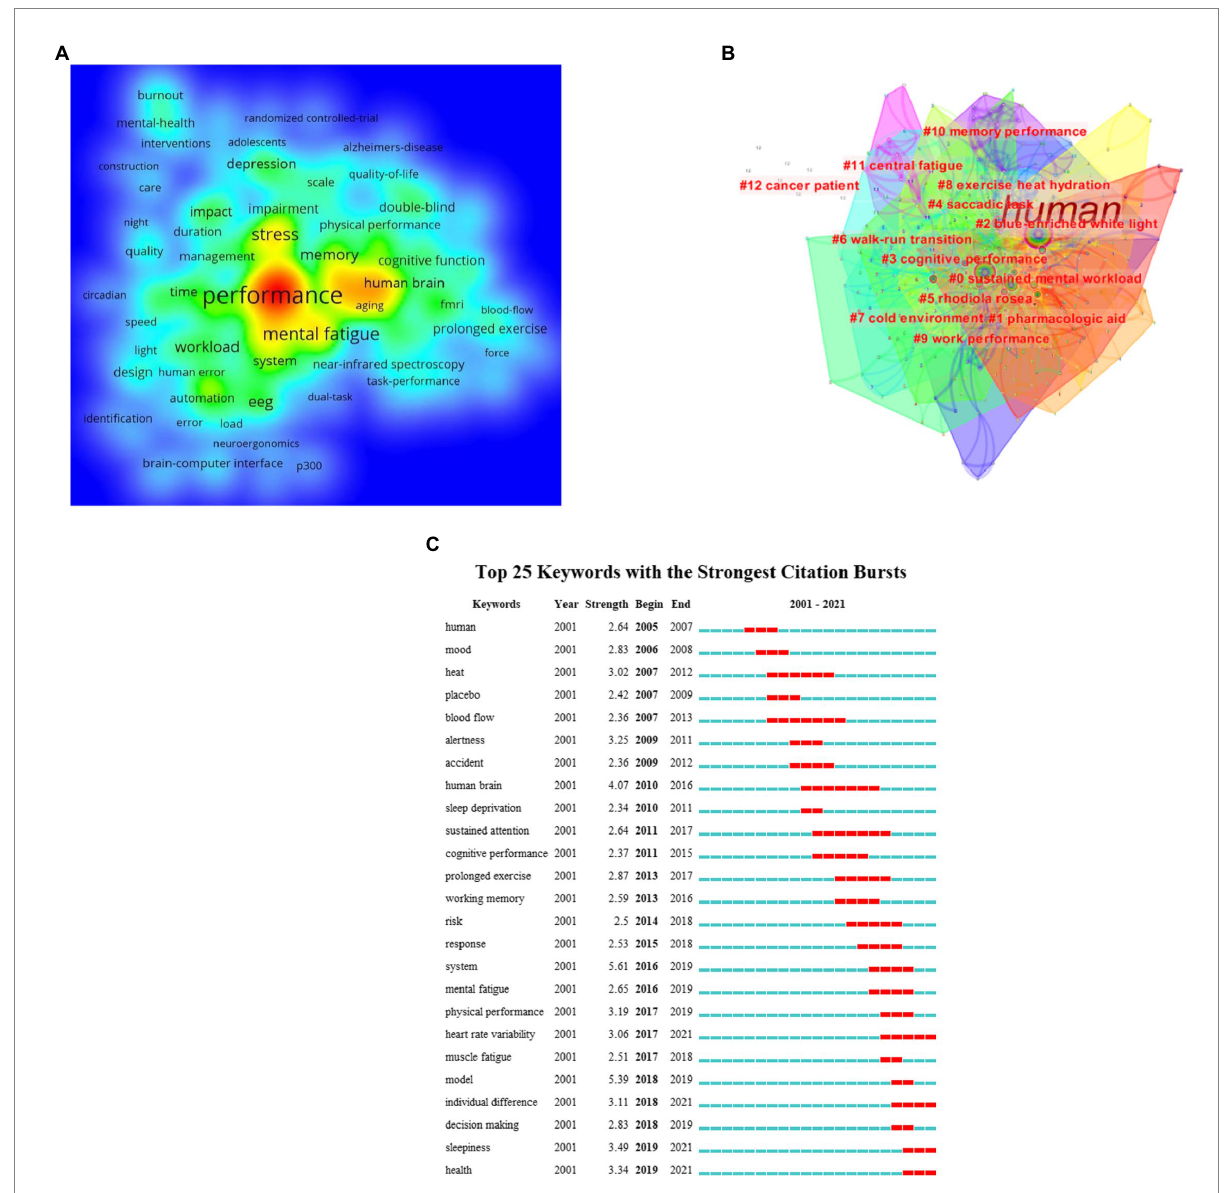
FIGURE 8 (A) The density visualization map of references based on VOSviewer; (B) The keywords clustering based on LIR method; (C) Top 25 keywords with the strongest citation bursts based on CiteSpace. The red horizontal stripes represent the years with the most frequent publications. The green horizontal stripes represent the years with the most infrequent